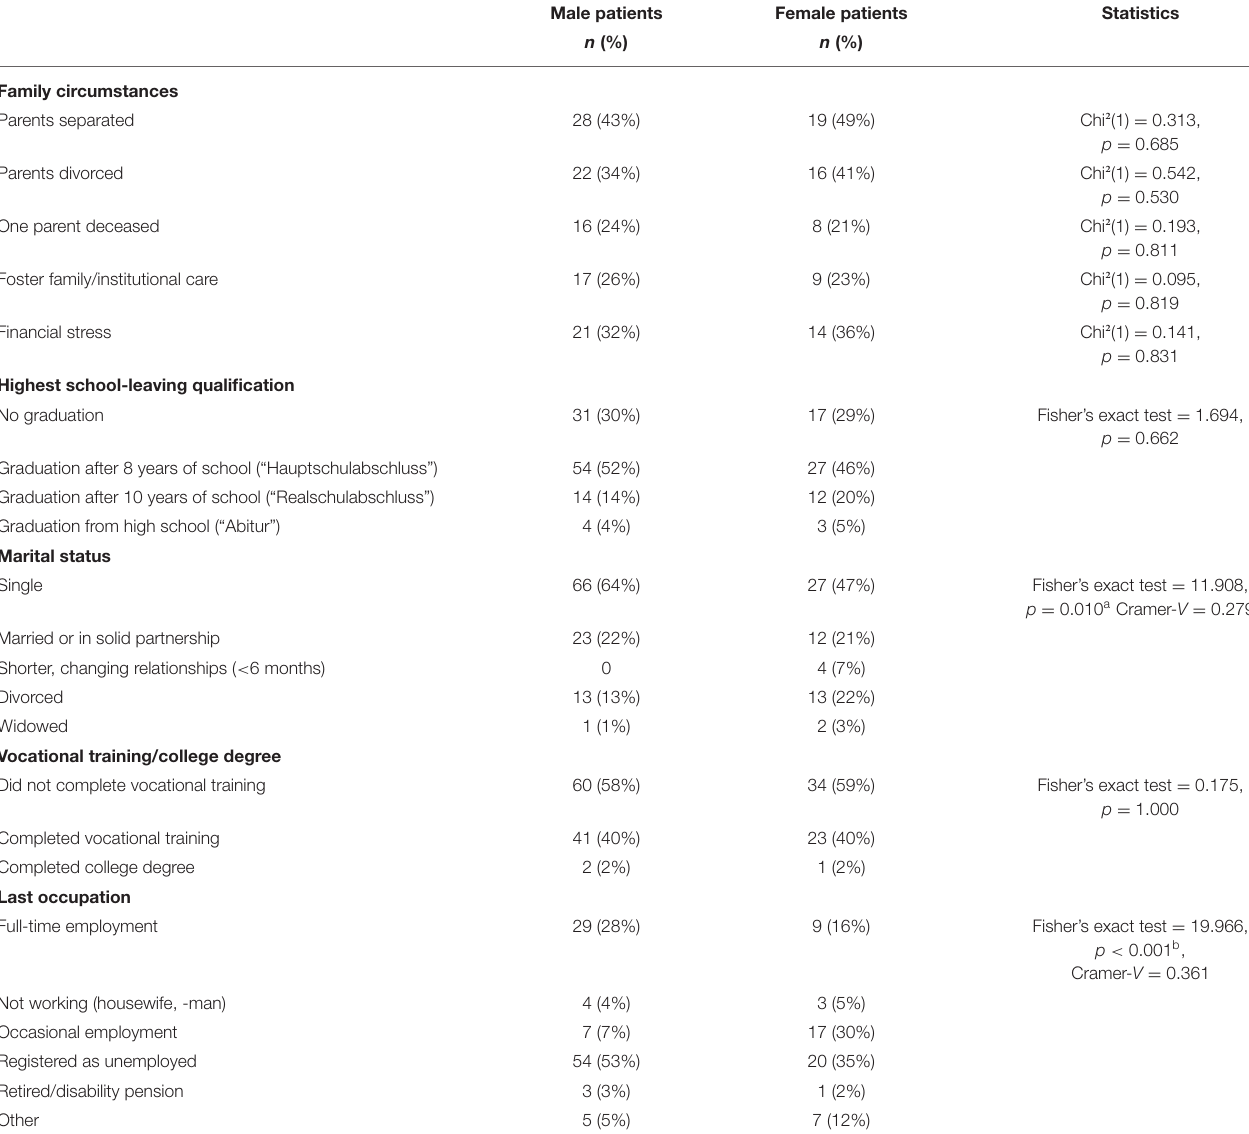
TABLE 1 | Frequencies of socio-demographic variables in male ( n = 115) and female ( n = 61) forensic psychiatric inpatients with substance use